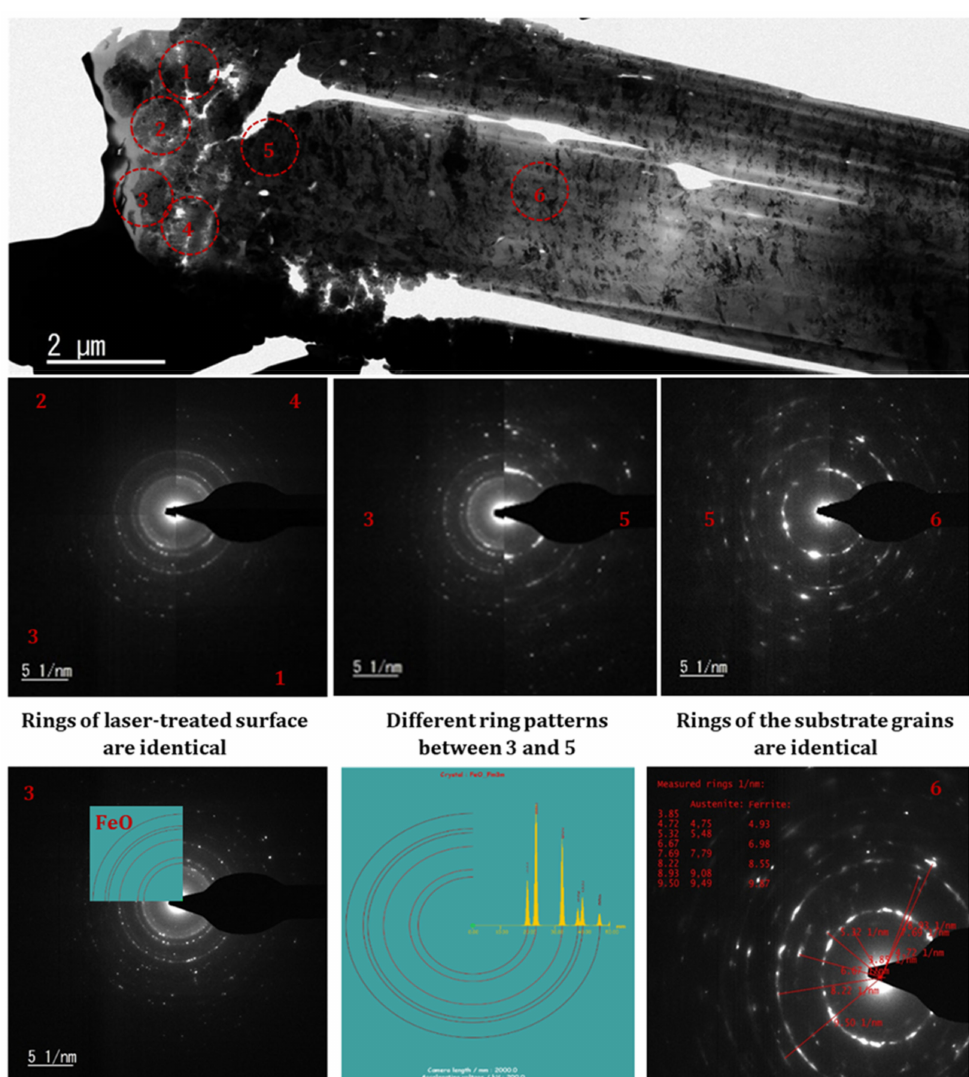
Figure 6. TEM analysis of the sample irradiated at CH = 1561 J/cm 2